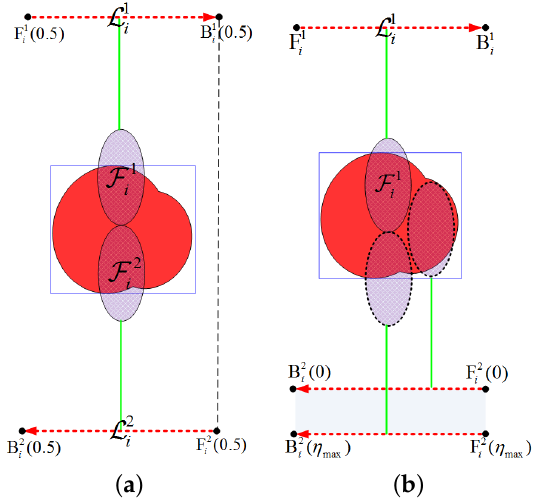
opt j opt i ,2 i ,1 = mod ( ˆ θ j + 180,360 ) . ( a ) η = η = 0.5 in searching 2 1 i ,2 i ,1